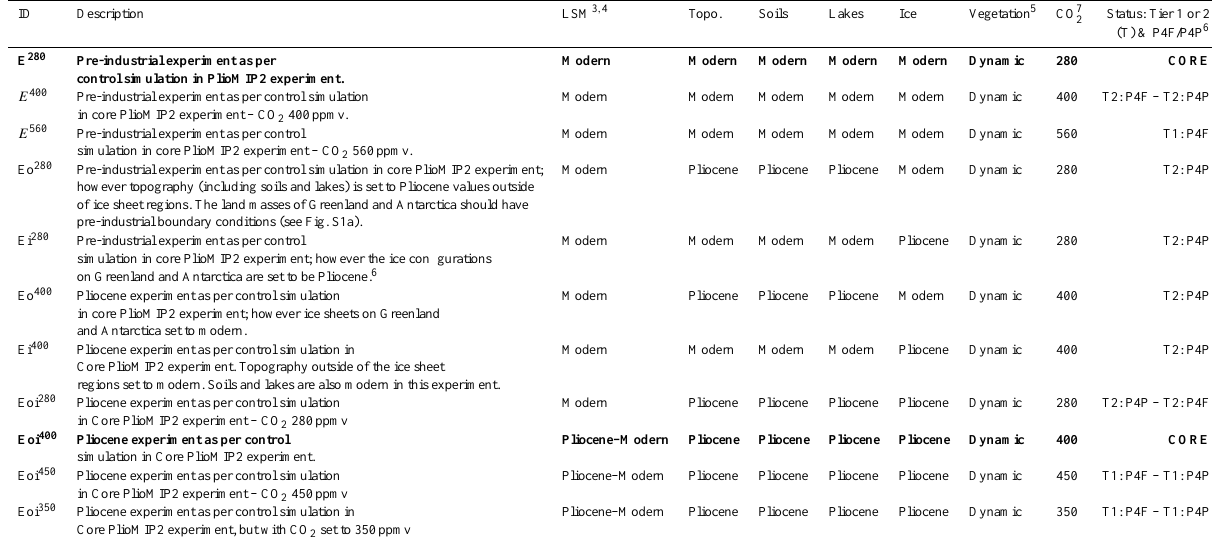
Table 3. Details of all experiments proposed in PlioMIP Phase 2.